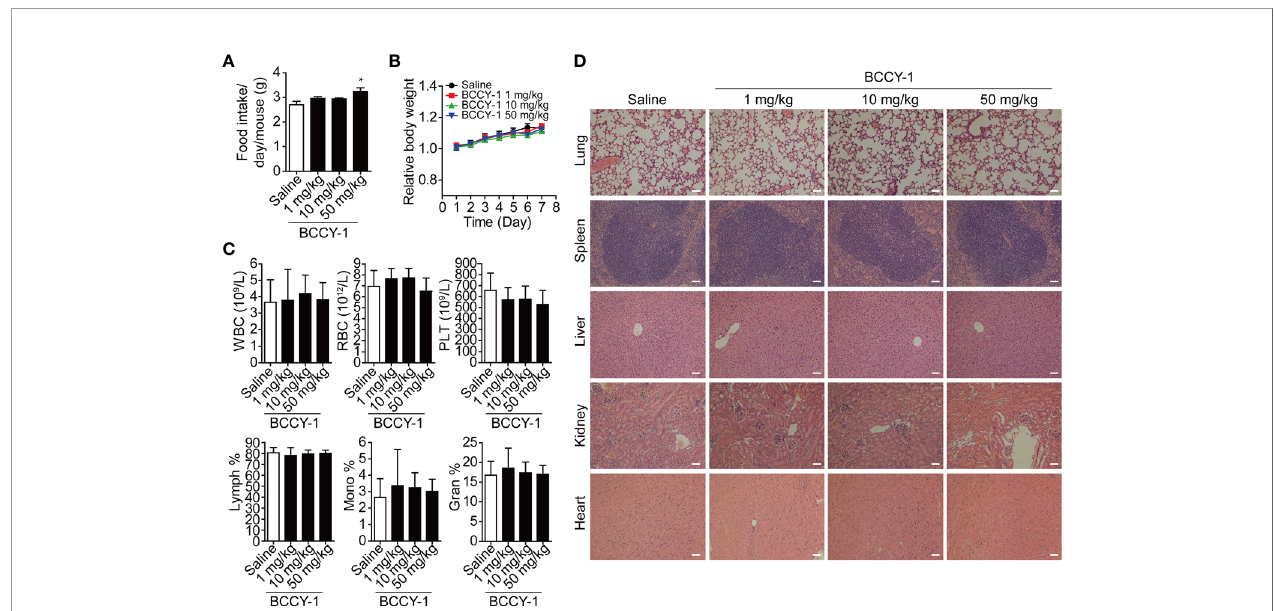
FIGURE 1 | Effects of BCCY-1 on organ toxicity. (A) food intake/day/mouse and (B) body weight were monitored daily after i.p. injection of peptide BCCY-1 at indicated concentration. Results are expressed as the body weight relative to the initial body weight. * p < 0.05. (C) Routine blood analysis was performed after BCCY-1 treatment. WBC, White blood cell; RBC, red blood cell; PLT, platelet; Lymph, lymphocyte; Mono, monocyte; Gran, granulocyte. (D) Representative histological images of the lung, spleen, liver, kidney, and heart of mice stained with H&E after BCCY-1 treatment. Bar = 50 m